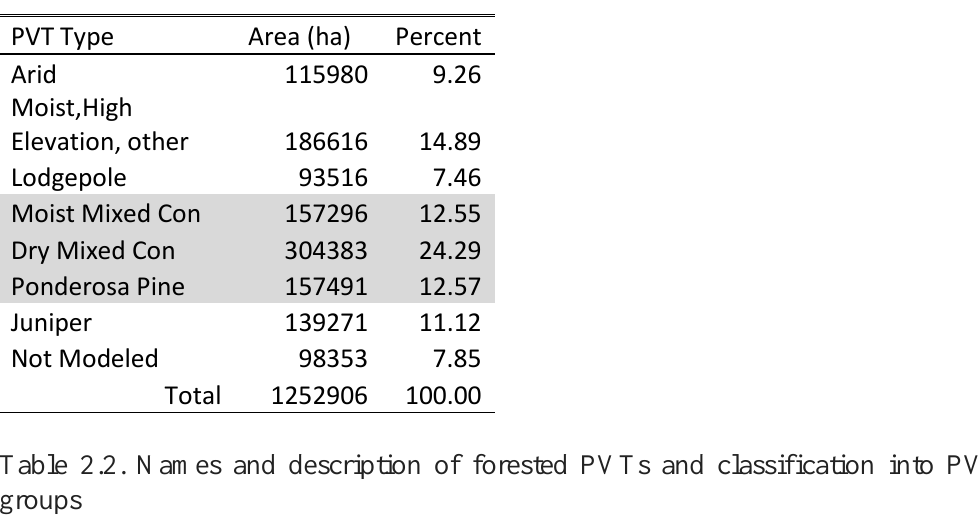
Table 2.1. Percent of study area of potential vegetation (PVT) type groups. Groups combine 39 individual PVTs. Fire-frequent types used in landscape analysis are shaded.